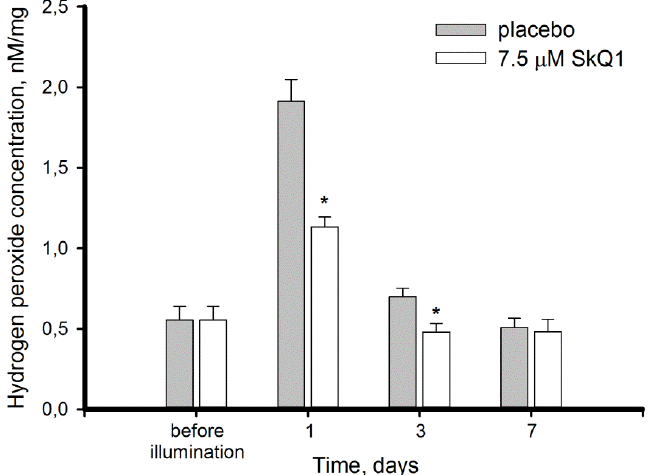
Figure 3. Hydrogen peroxide content in extracts of intact and illuminated rabbit retinas with or without premedication with 7.5 µ M SkQ1. Hydrogen peroxide concentration was measured by Fe 2+ /o-dianisidine/xylenol orange colorimetric assay. Each bar represents the data obtained from six animals (12 eyes). * p ≤ 0.05 compared with the values measured in the control